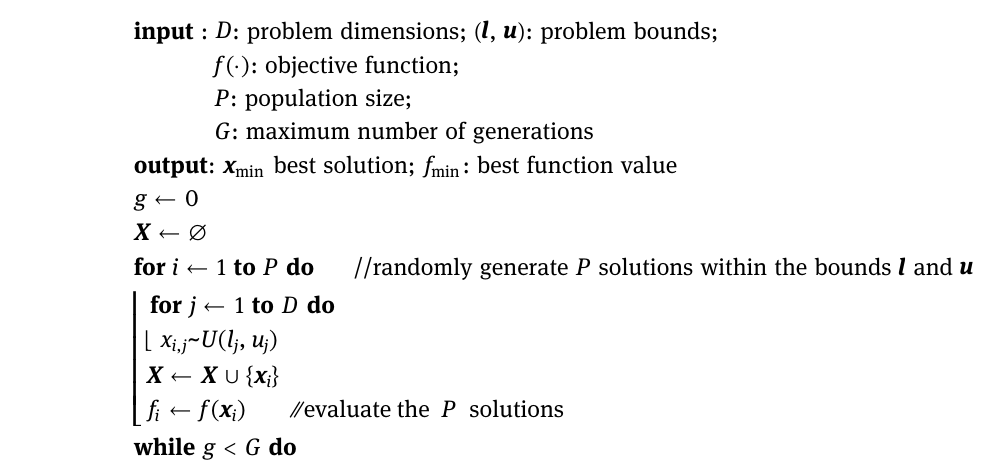
Algorithm 1: The Jaya